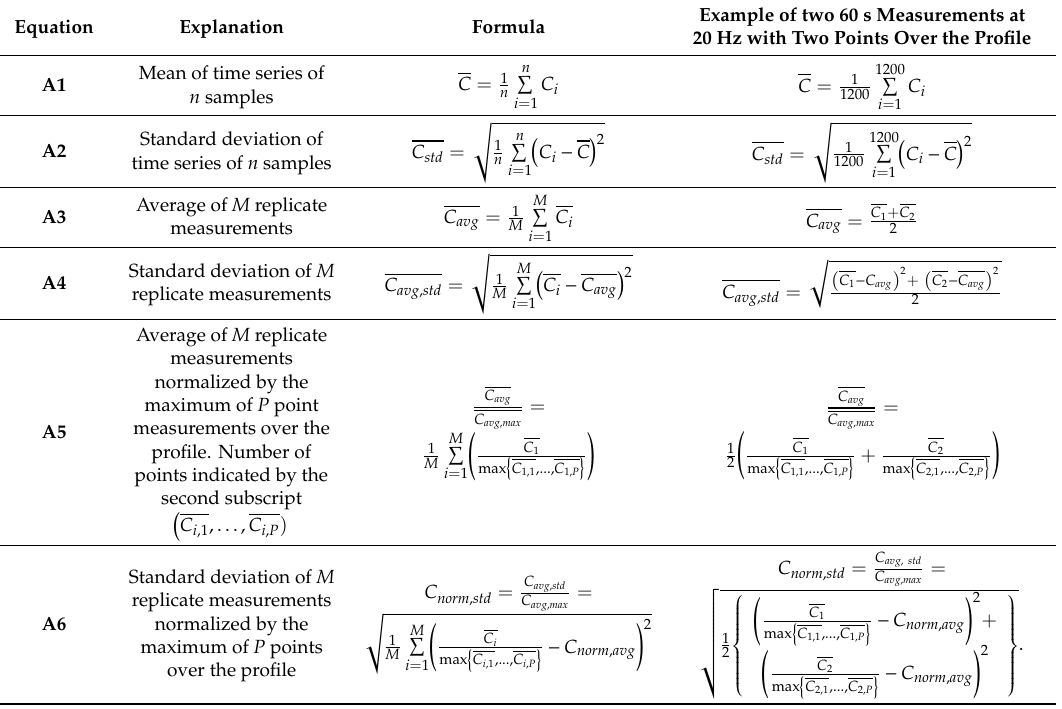
Table A1. Formulas used for calculating the time-averaged C and average C avg